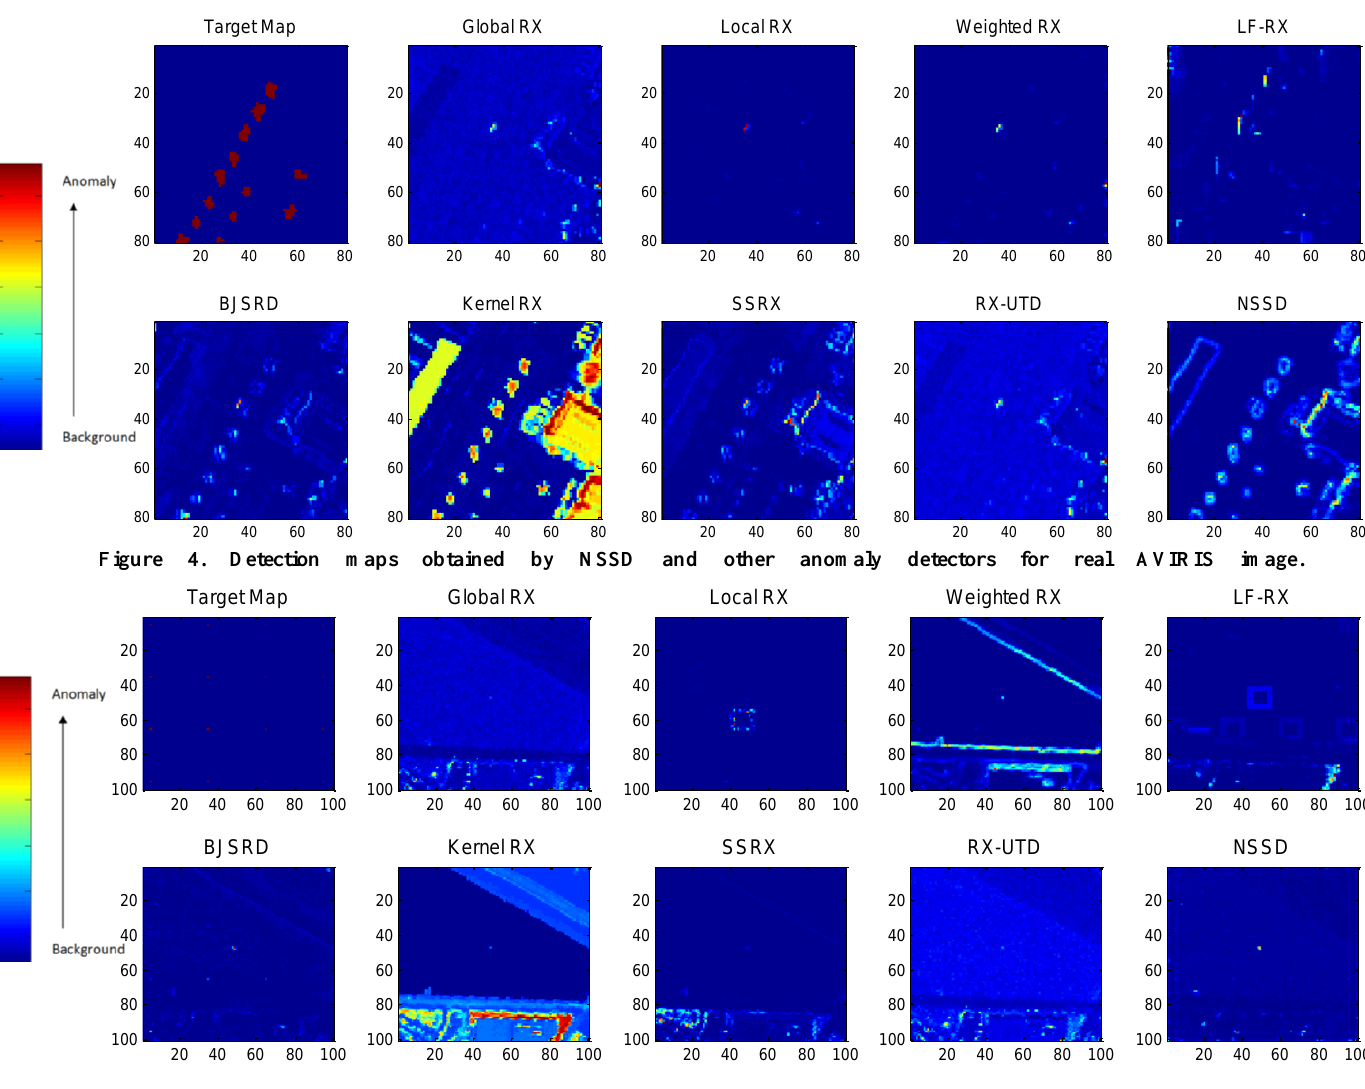
Figure 5. Detection maps obtained by NSSD and other anomaly detectors for synthetic